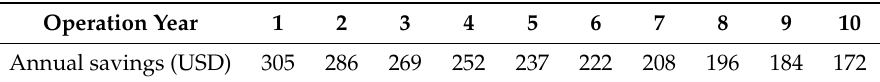
Table 1. Electricity annual savings for each operation year with example simple tariff.